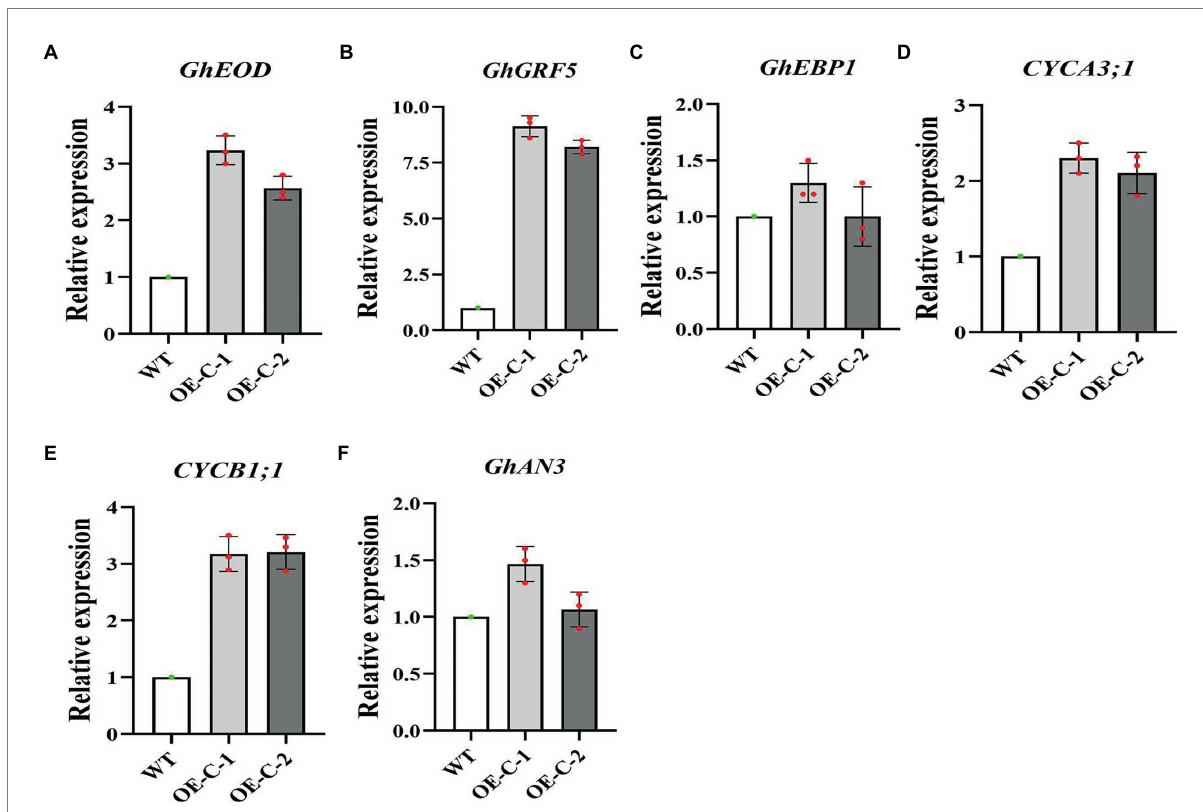
FIGURE 3 Expression analysis of genes related to growth and development in the transgenic cotton lines. (A) GhEDO Relative expression. (B) GhGRF5 Relative expression. (C) GhEBP1 Relative expression. (D) CYCA3;1 Relative expression. (E) CYCB1;1 Relative expression. (F) GhAN3 Relative